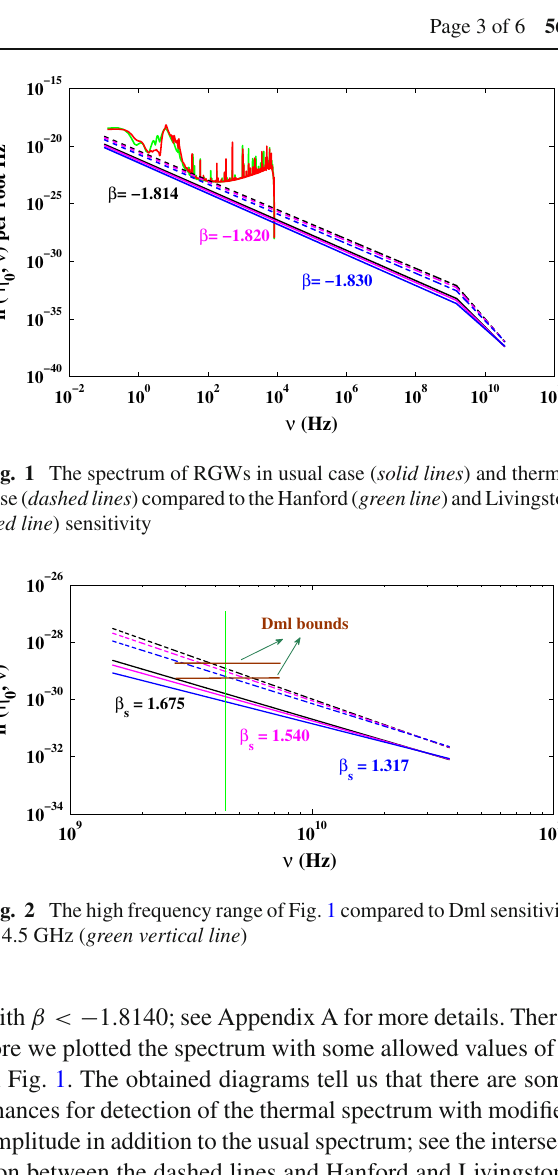
tion between the dashed lines and Hanford and Livingstone sensitivity in Fig. 1. Also the obtained values of β give us more information as regards the evolution of inflation stage; see Eq. (A.2) in Appendix